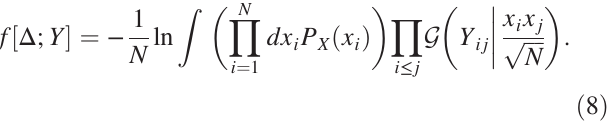
decreases, the equilibrium value (yellow) is reached first by the s ¼ 1 curve, corresponding to the performance of AMP.